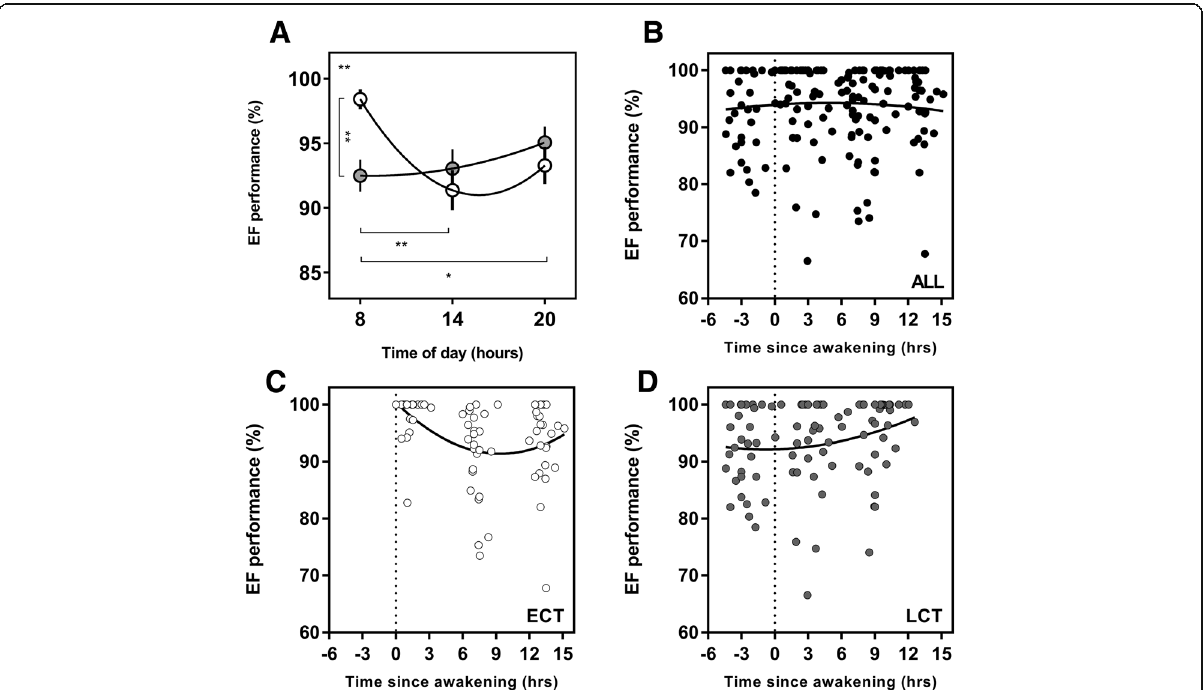
Fig. 3 Diurnal variation in executive function (EF) and EF as a function of time since awakening. Clock time variation ( a ) in PVT performance between ECTs (white circles) and LCTs (grey circles). EF as a function of time since awakening for all subjects ( n = 56; b ), ECTs ( n = 25; c ), LCTs ( n = 31; d ). Data are expressed as the percentage of individual personal best performance. Entrained wake-up time, i.e. biological time 0, is shown with the dotted line. Curves are second-order polynomial non-linear regressions. The significance is shown as * = p < 0.05, ** = p < 0.01, *** = p < 0.001, **** p < 0.0001. The result shown in the upper left of ( a ) plots represents the interaction between the time of day and chronotype derived from the overall two-way ANOVA. Post hoc test results are shown with lines and asterisk between the time of day and chronotype